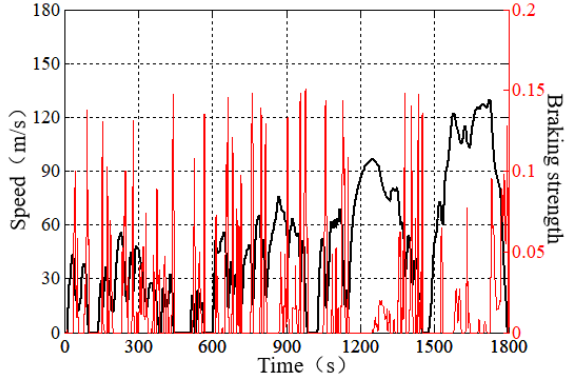
Figure 15. Working condition of WLTC.